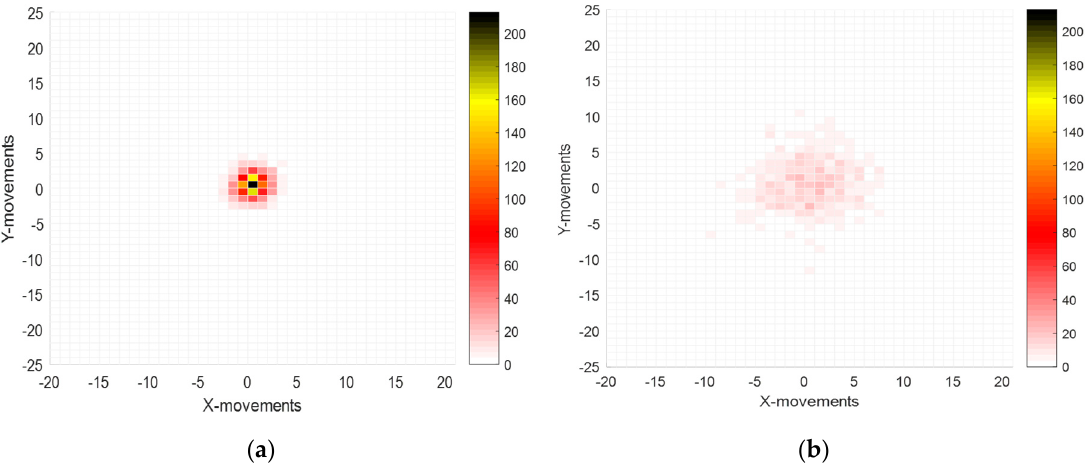
Figure 9. 2D histogram of temporal fluctuations measured at z 3 : ( a ) Pattern Test. ( b ) Test #1. Source: Authors.